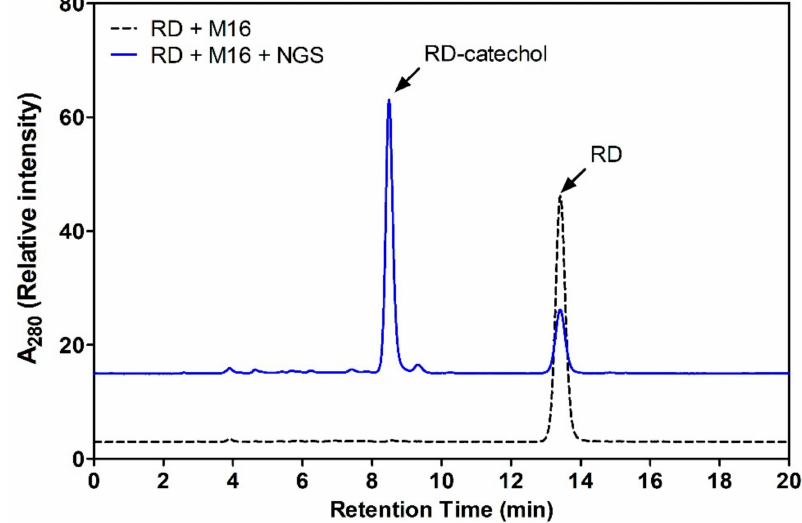
Figure 2. High-performance liquid chromatography (HPLC) chromatogram of RD and RD-catechol produced by engineered CYP102A1. The reaction mixtures contained 0.2 µ M M16 or 200 µ M RD with or without NADPH regenerating system (NGS). RD and RD-catechol were eluted at 13.4 and 8.4 min,